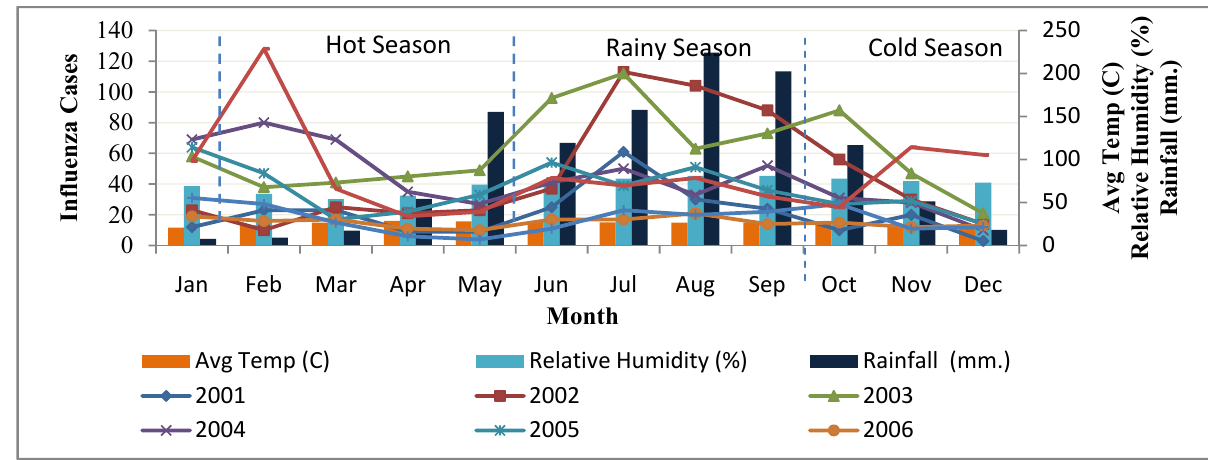
Figure 4. Number of influenza cases with average rainfall, relative humidity and temperature on monthly during the years